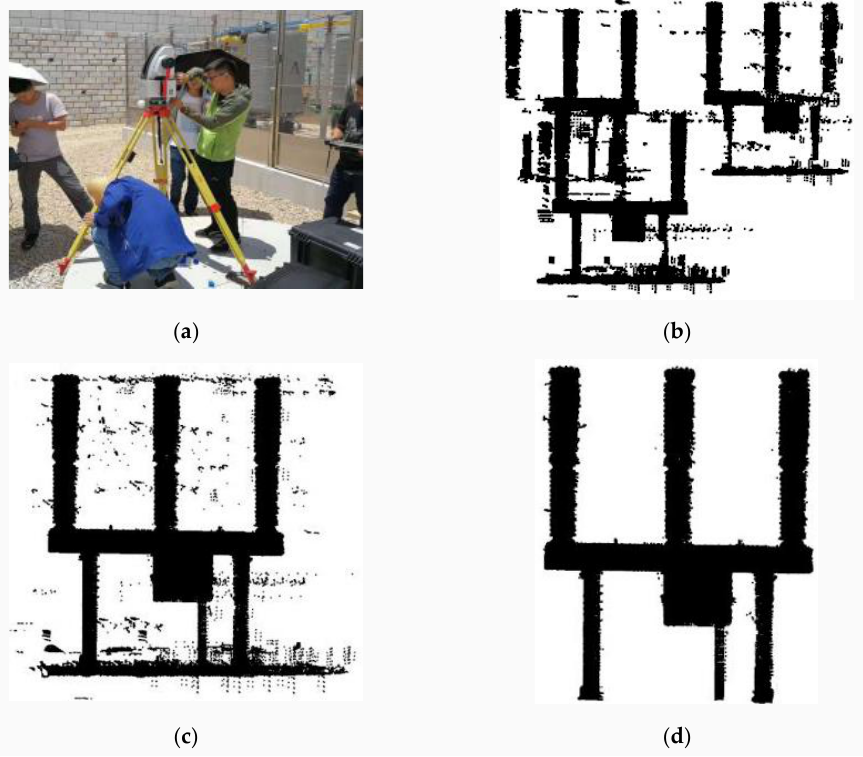
Figure 8. Collection and processing of point cloud data. ( a ) Collection of point cloud data. ( b ) Original